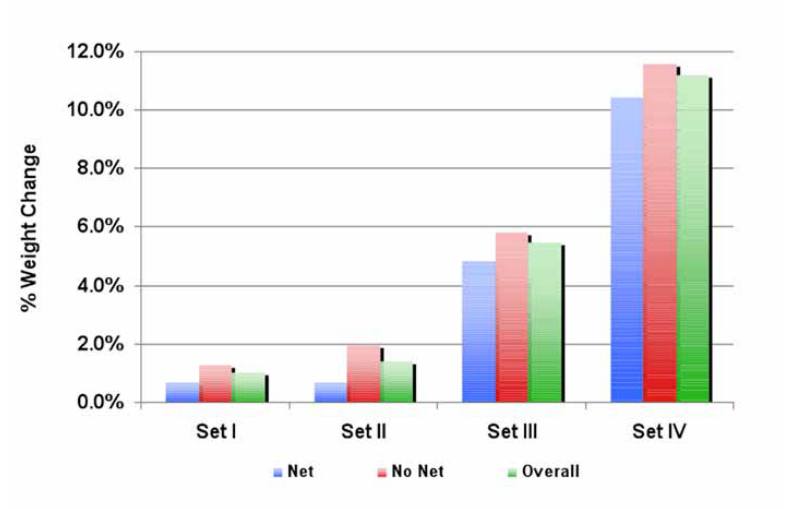
Figure 3 - Relative weight difference for each laser setting considering overall performance and separate trials with and without the stone entrapment